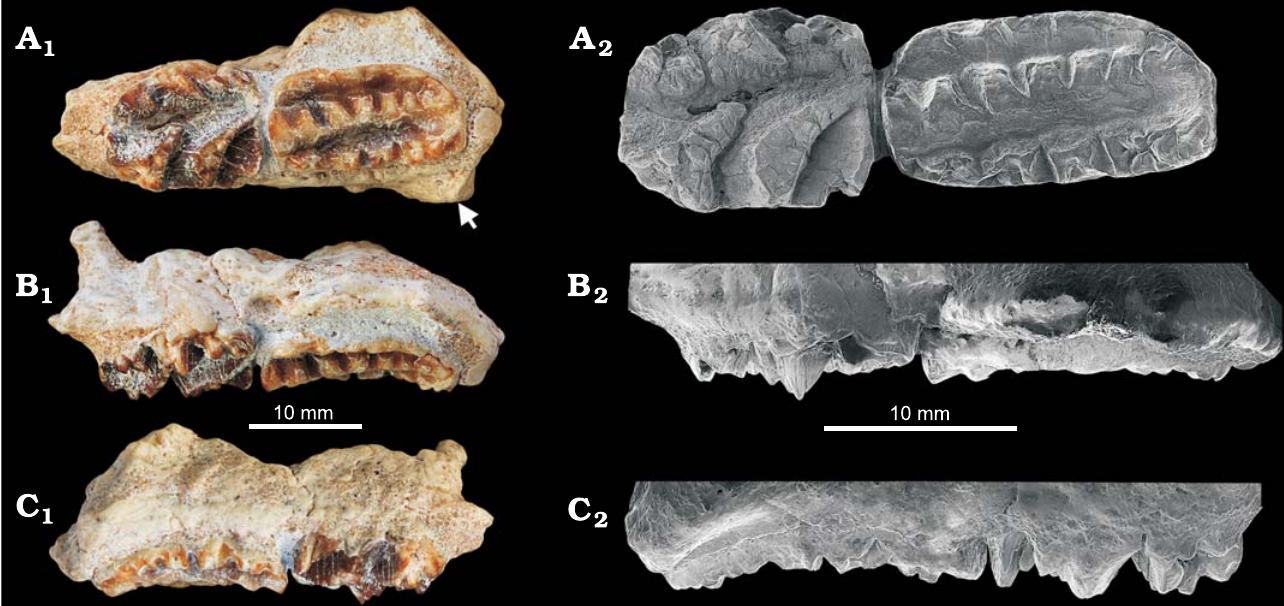
Fig. 5. Multituberculate mammal Sphenopsalis nobilis Matthew, Granger, and Simpson, 1928 (IVPP V19032) from the upper Paleocene Nomogen beds at the Erden (Urtyn) Obo locality, Inner Mongolia, China. Left upper molars (M1–2) from the same individual as the lower ones in Fig. 7 in occlusal ( A ), medial ( B ), and lateral ( C ) views. The arrow indicates the broken anterior root of the zygomatic arch. Photographs (A 1 –C 1 ), SEM images (A 2 –C 2